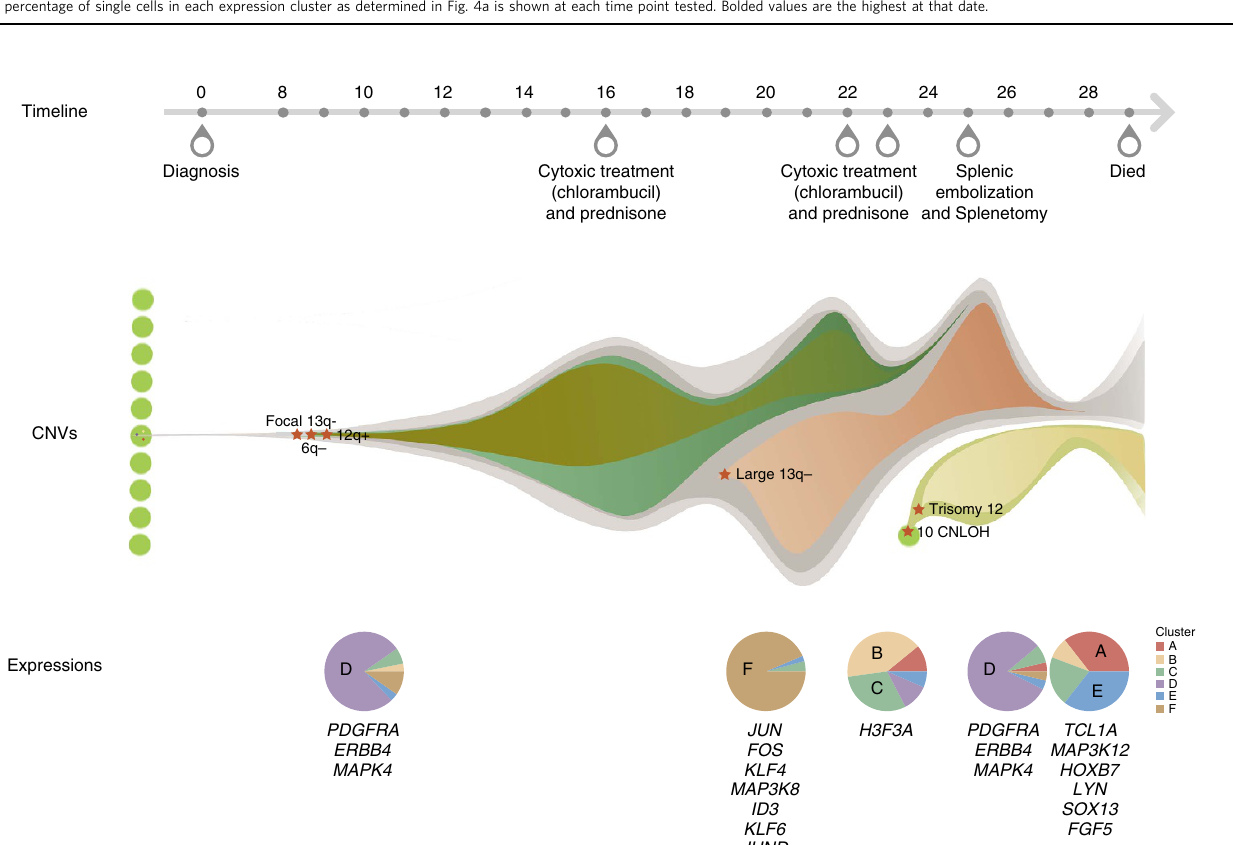
Figure 5 | The inferred tumour evolution path of the CLL patient. The upper panel represents the timeline of the main treatments. The middle panel represents the inferred CNVs evolution model and the lower panel represents the percentage of cells from different clusters at expression